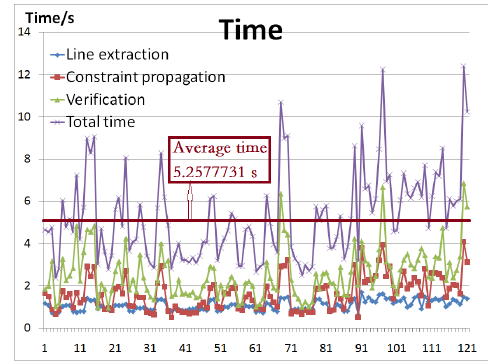
Figure 10. The time our method required for the dataset of images. The horizontal axis shows the input image index, and the vertical axis shows the time the current approach required. For one input image, the total time our method required was approximately 5